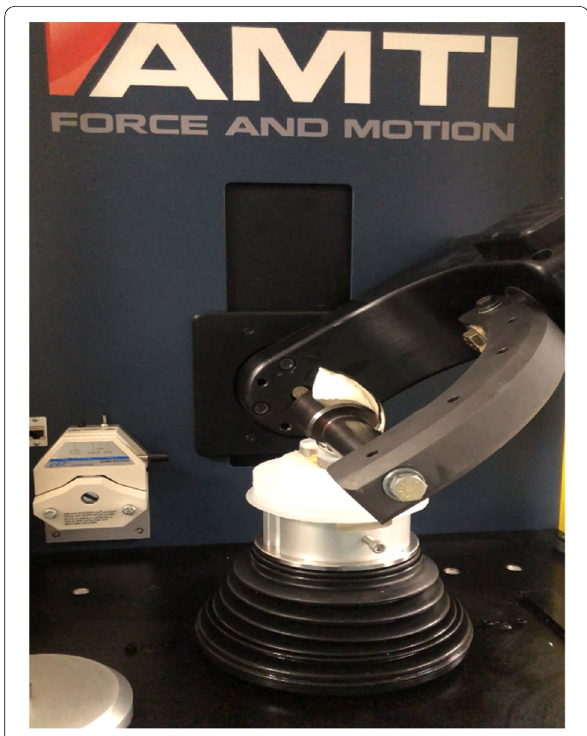
Fig. 1 VIVO 6 degrees of freedom joint motion simulator (AMTI, Watertown, MA,